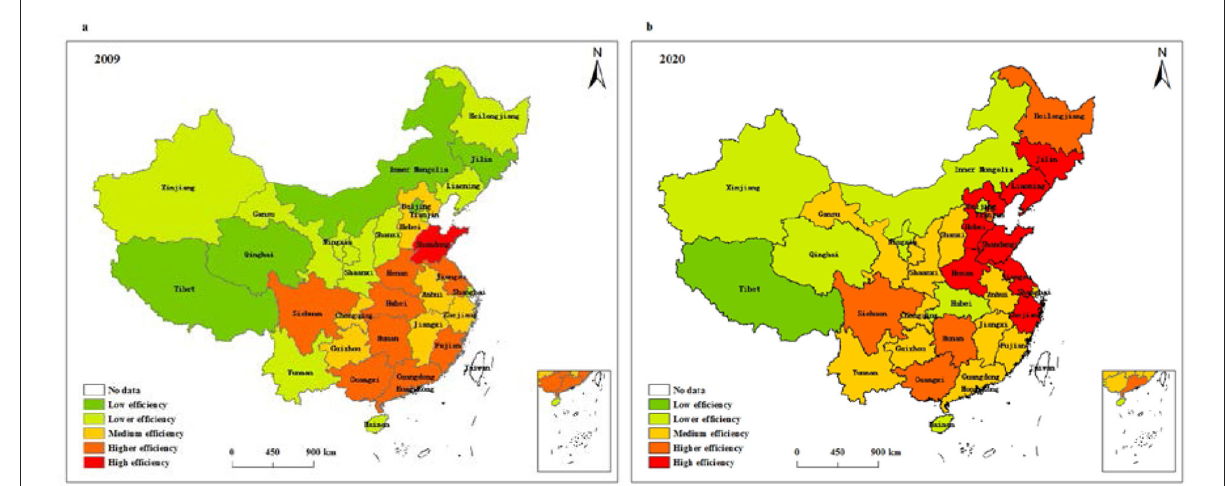
FIGURE5 Spatial pattern of overall health system efficiency in (a) 2009 and (b) 2020.